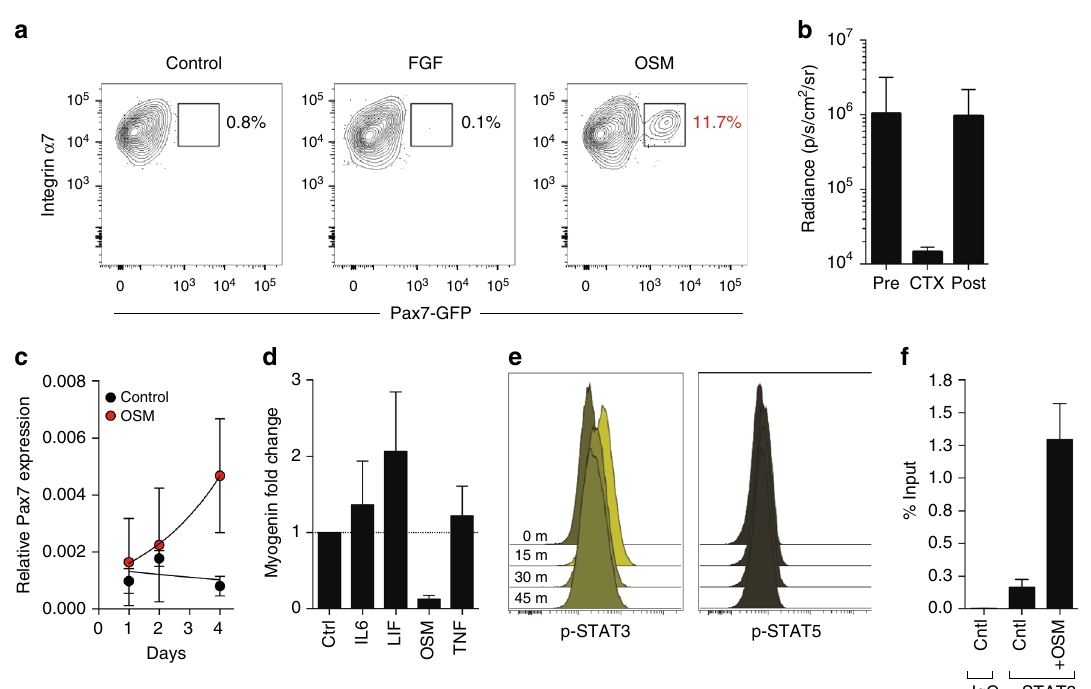
Fig. 3 OSM treatment enhances stem cell serial transplantation and inhibits differentiation. a FACS analysis of stem cells reisolated from primary transplant recipients receiving either control (left), FGF (middle), or OSM-treated (right) stem cells. Only the live, CD11b − Sca1 − CD31 − CD45 − CD34 + α 7 integrin + stem cell population is shown. b MuSCs (CD11b - Sca1 - CD31 - CD45 - CD34 + α 7 integrin + GFP + ) were reisolated from OSM primary transplant mice as described in a , transplanted equally into 5 limbs (secondary transplant recipients; 50 MuSC/limb; 8 – 12 week old recipients), and monitored by serial BLI. At day 25 following transplant, cardiotoxin (CTX) was injected to induce myo fi ber damage and stimulate stem cell expansion and tissue regeneration. The average radiance at each timepoint is indicated, and demonstrates regenerative capacity (BLI signal loss followed by rebound) of serially transplated OSM-treated MuSC. Percentage of engrafted mice was 40% both pre and post-CTX injury (2/5 total mice). Note that untreated cells give no engraftment, and no MuSC are therefore present for reisolation/transplant. c qRT-PCR analysis of Pax7 expression following 6day culture of FACS-sorted MuSC in the presence of OSM (gray circles) or buffer control (black). Mean±SD is shown, n = 3 replicates. d qRT-PCR analysis of myogenin expression following 6day culture of FACS-sorted MuSC with the indicated cytokines and growth factors. Expression was normalized to GAPDH expression. Mean±SD is shown, n = 3 replicates. e Timecourse intracellular fl ow cytometry of primary mouse myoblasts treated for the indicated period of time with OSM, and stained for either phospho-STAT3 (left) or phospho-STAT5 (right). 0 (unstimulated), 15, 30, and 45min timepoints are shown following cytokine addition. Frequencies are represented as histograms. f ChIP performed using primary myoblasts cultured for 6 days either with or without OSM. Immunoprecipitation was performed with either control IgG or STAT3-speci fi c antibodies, and PCR was performed using primers speci fi c for a predicted STAT3 binding site adjacent to the Pax7